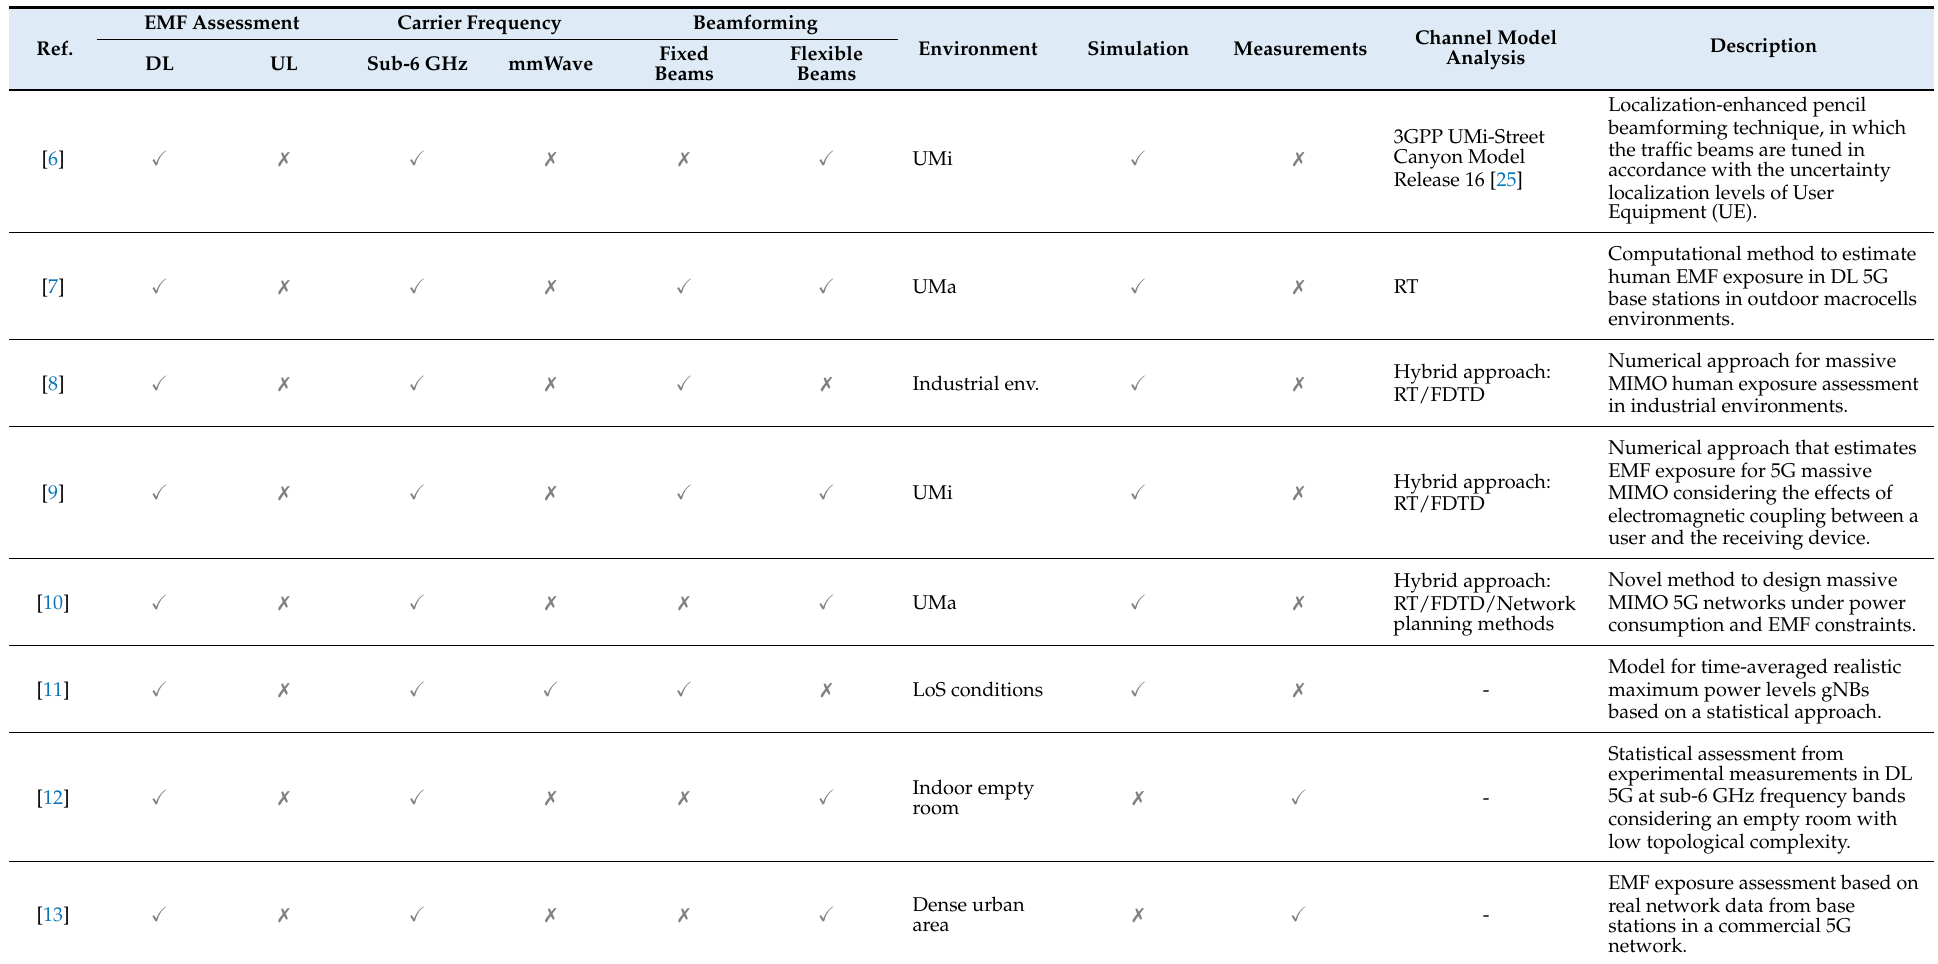
Table 1. Different methodologies for the assessment of RF-EMF exposure for 5G.